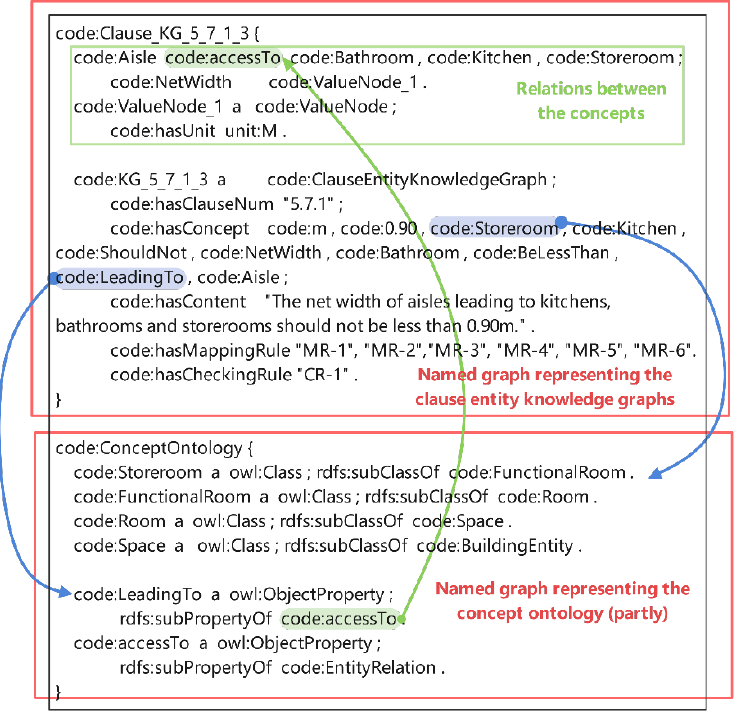
Figure 14. Example of an RDF dataset to store a clause-entity knowledge graph and the concept ontology.